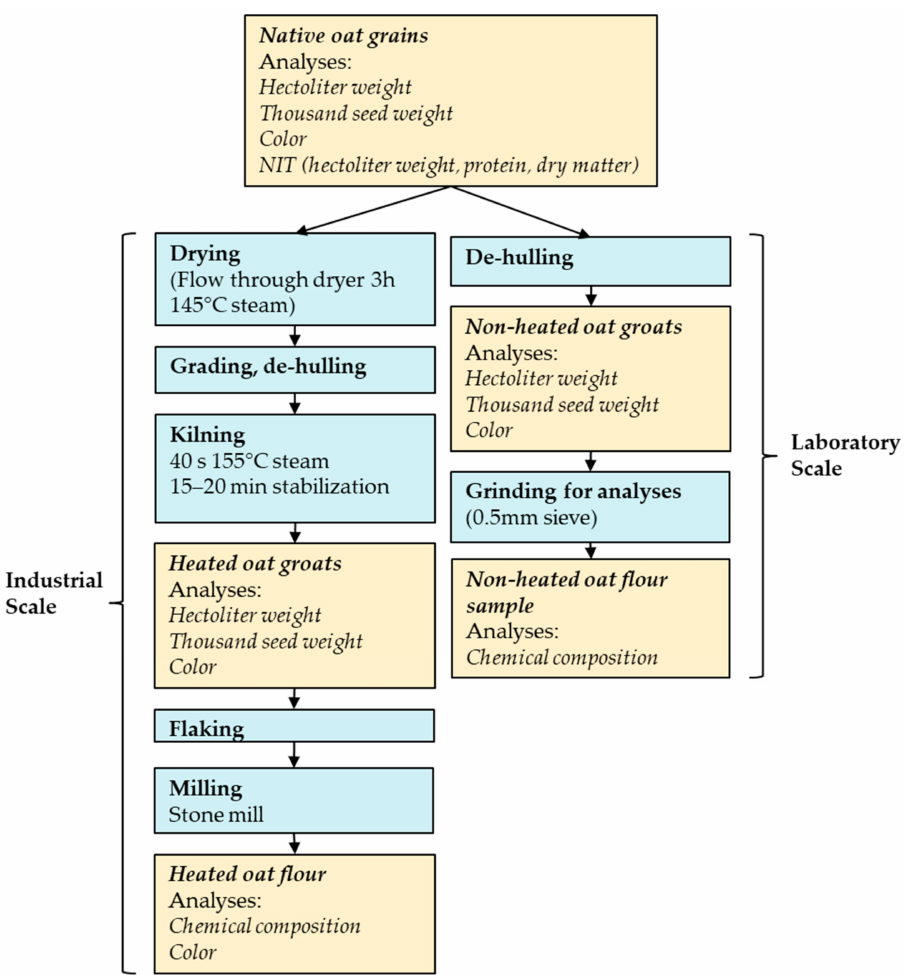
Figure 1. Processing scheme of the oat raw materials. The raw materials and subsequent analyses are shown in the yellow boxes, with the processing steps in